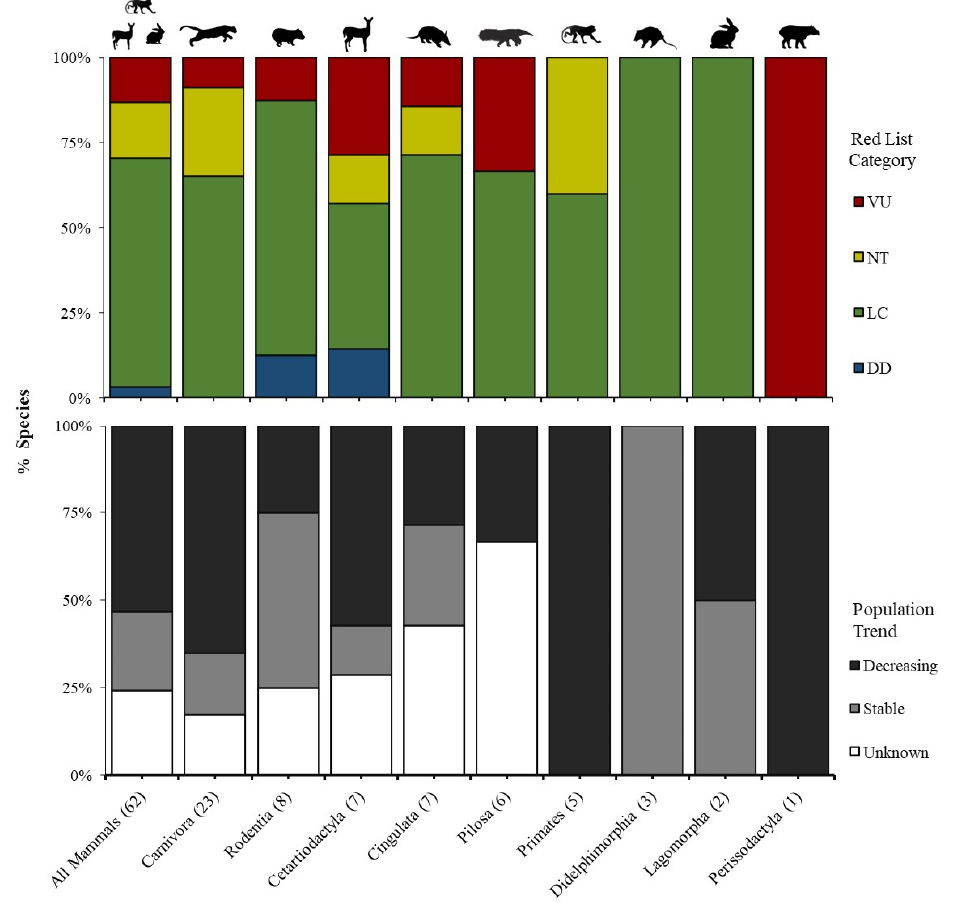
Figure 3. Percentage of medium–large mammals road-killed in Brazil according to the IUCN Red List category (Data Deficient (DD), Least Concern (LC), Near Threatened (NT), Vulnerable (VU)), and direction of population trends by taxonomic order. In parenthesis: road-kill species richness.